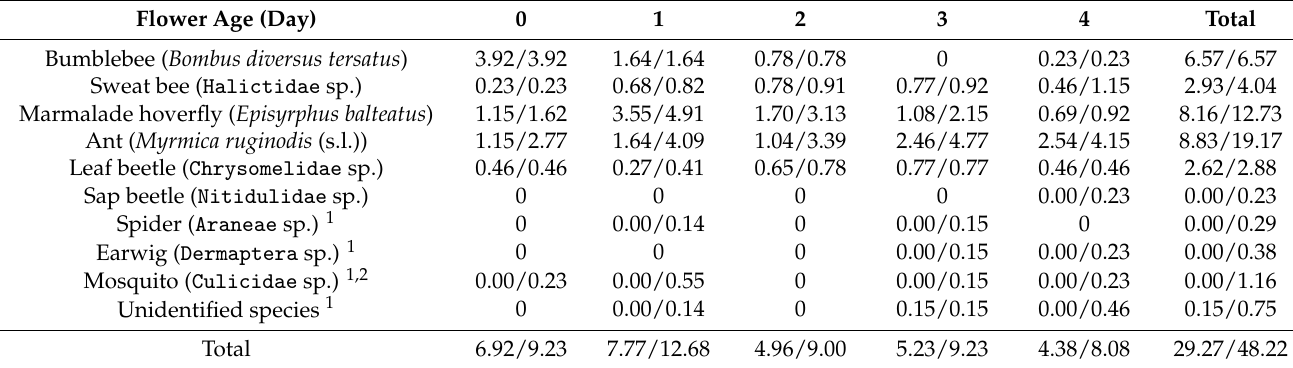
Table 1. The observed frequency of flower-visiting species per unit observational time (visits hour − 1 flower − 1 ). Flowering age = 0 is defined as the first day of the flowering for each individual flower. In each cell, the fraction X/Y indicates that a total of Y individuals arrived at the flower per hour (including those that only arrived at the outer (abaxial) surface of the corolla), and among them, X entered inside a flower tube (i.e., the adaxial surface of a corolla). Flower Age (Day) 0